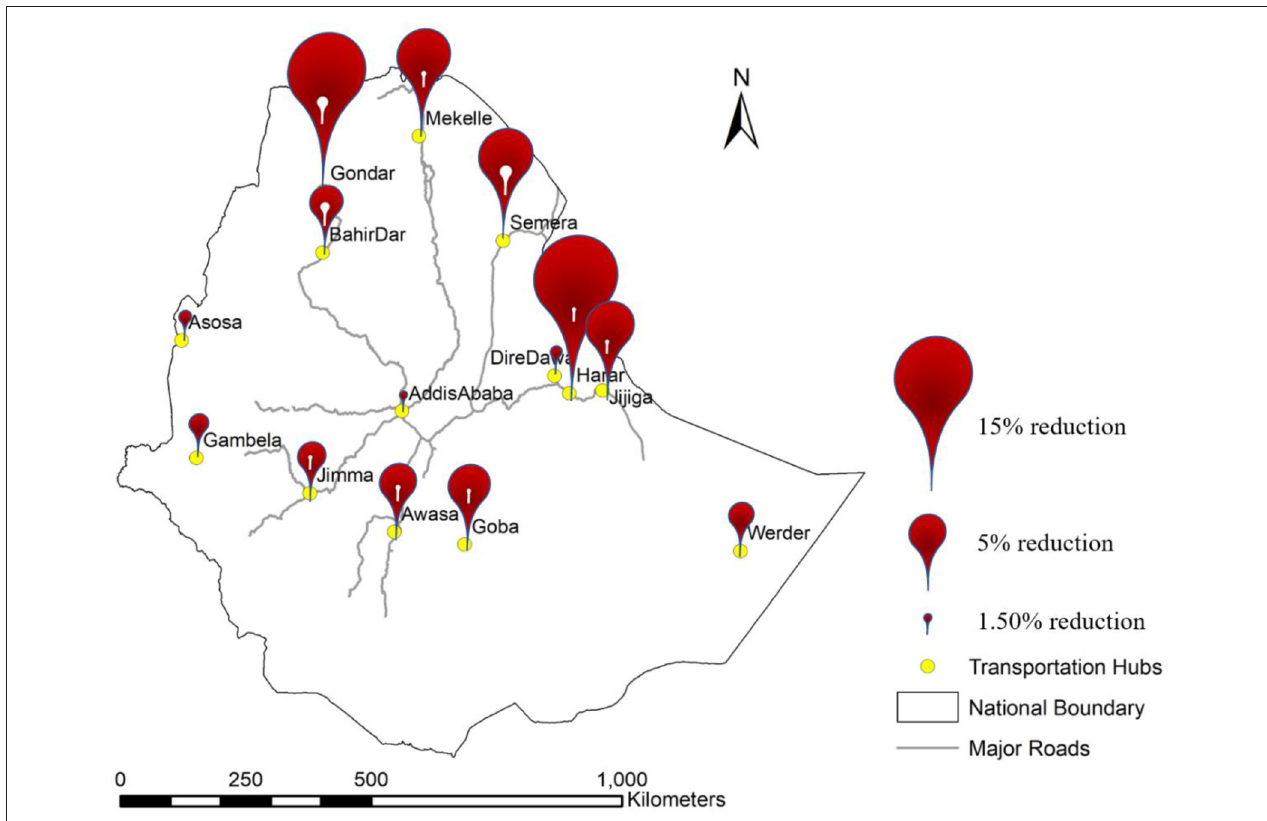
FIGURE 4 | Reduction in quantities sold in domestic markets relative to amount sold under an export ban. Red pin heads correspond to the free export scenario. White pinheads correspond to the scenario with an export cap of 200 thousand quintals per